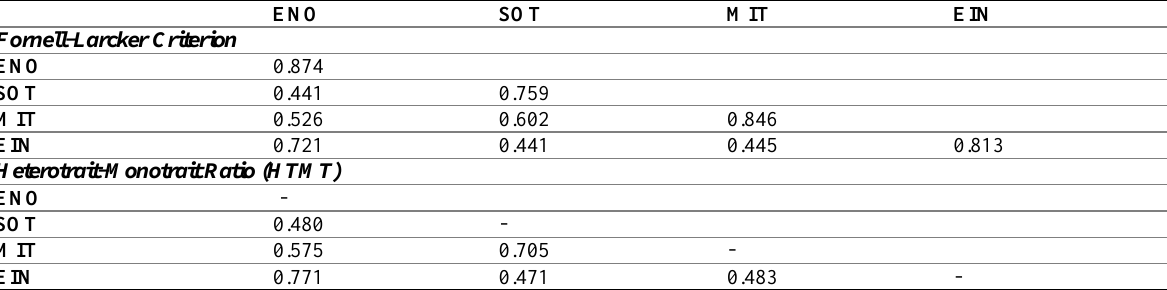
Table 6: Discriminant Validity (Stage 2)